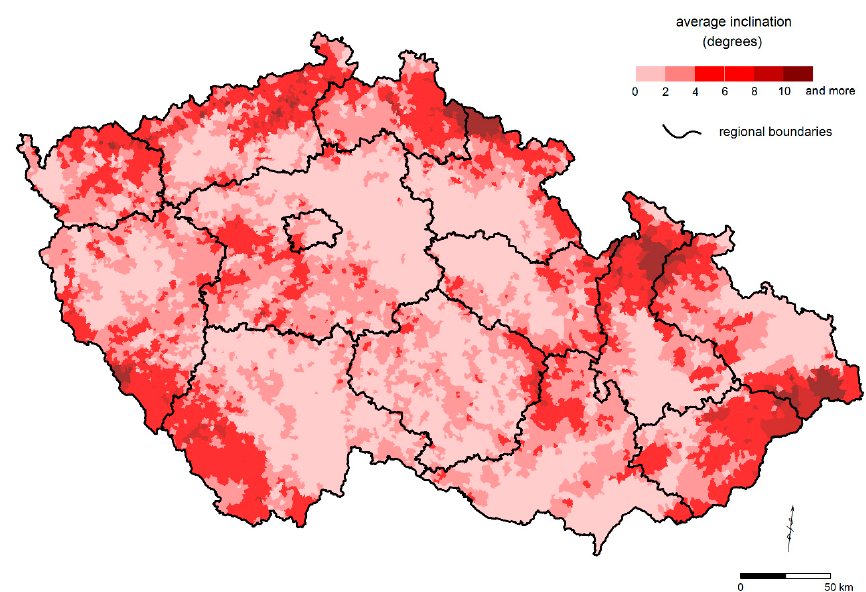
Figure 3. Average slope in the BTU of Czechia (°). Source: Arc Č R 500, own calculation.